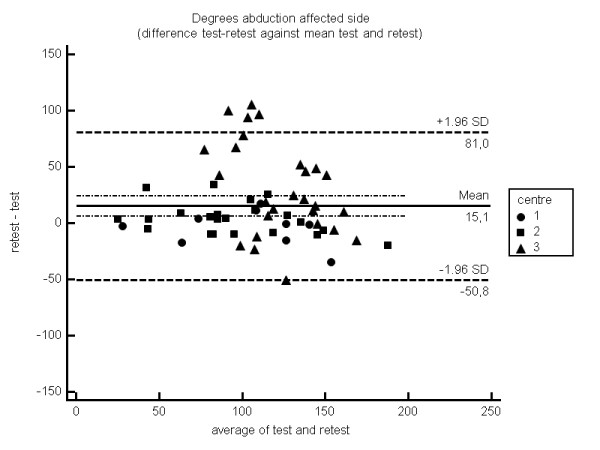
D-study results.